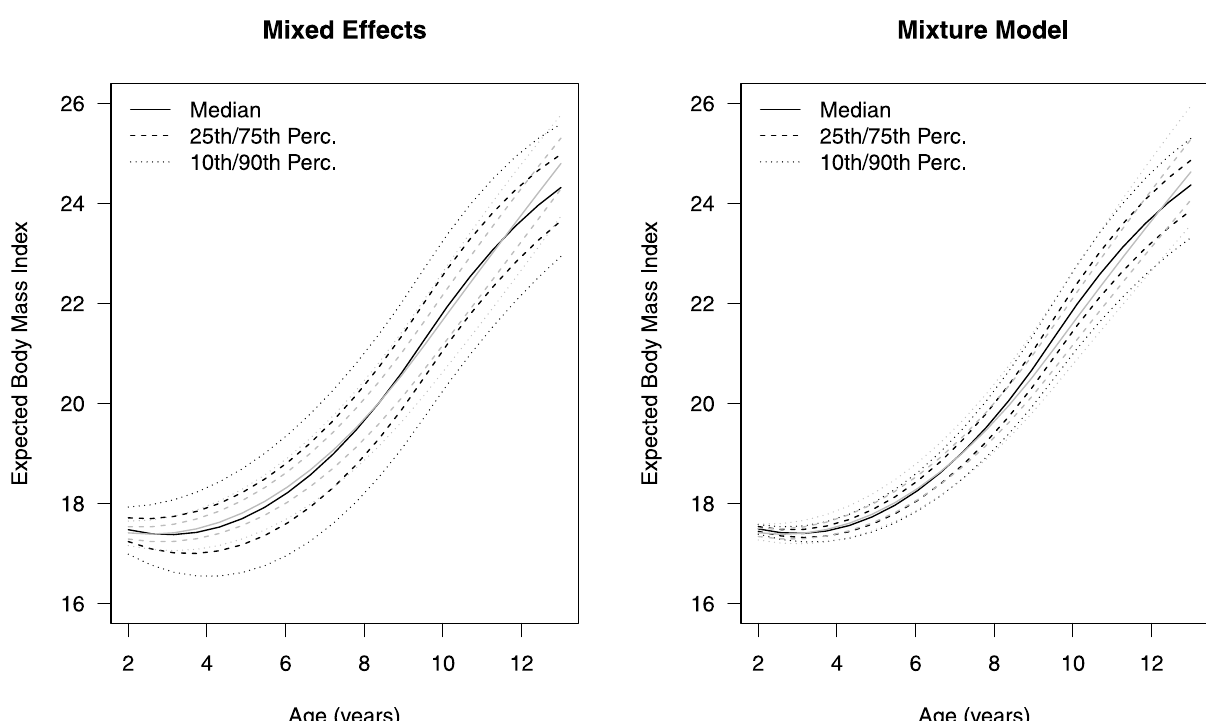
Fig 4. Model comparison. Estimated mean BMI for the 10th, 25th, 50th, 75th, and 90th percentiles of MEP for boys (dark) and girls (light), separately, based on a linear mixed effects model and a four-group growth mixture model fit to the CHAMACOS data.